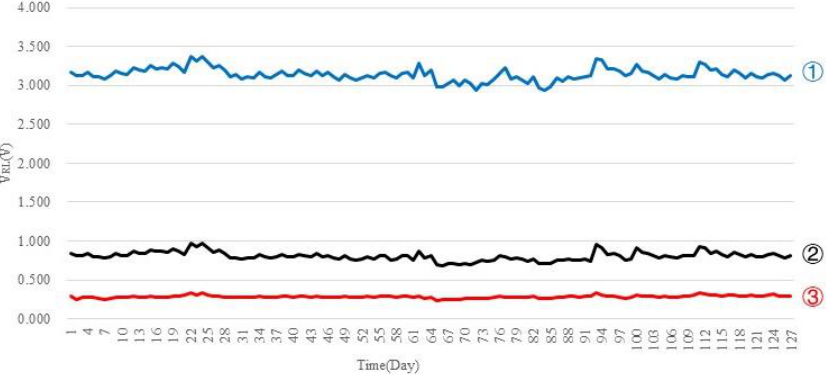
Figure 5. Data graph of sensors. ① . R l = R p , ② R l = (1/10) R p , ③ R l = (1/16) R p .